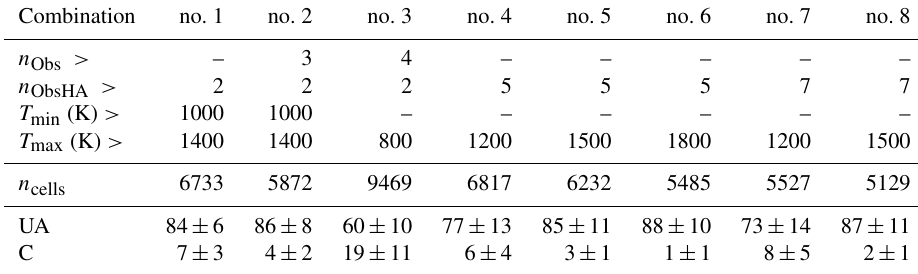
Table 1. User’s accuracy (UA, %) and commission error ( C , %) of the hot spot discrimination strategies considered. n Obs is the number of hot spot detections within a grid cell, n ObsHA is the number of high-accuracy hot spot detections within a grid cell, T min is the minimum temperature retrieved among all the hot spots detected within a grid cell, T max is the maximum temperature retrieved among all the hot spots detected within a grid cell, and n cells is the number of grid cells that comply with the thresholds. We have tried eight combinations (discrimination strategies) of thresholds on those variables. Each column represents a tested discrimination strategy. Combination no. 1 no. 2 no. 3